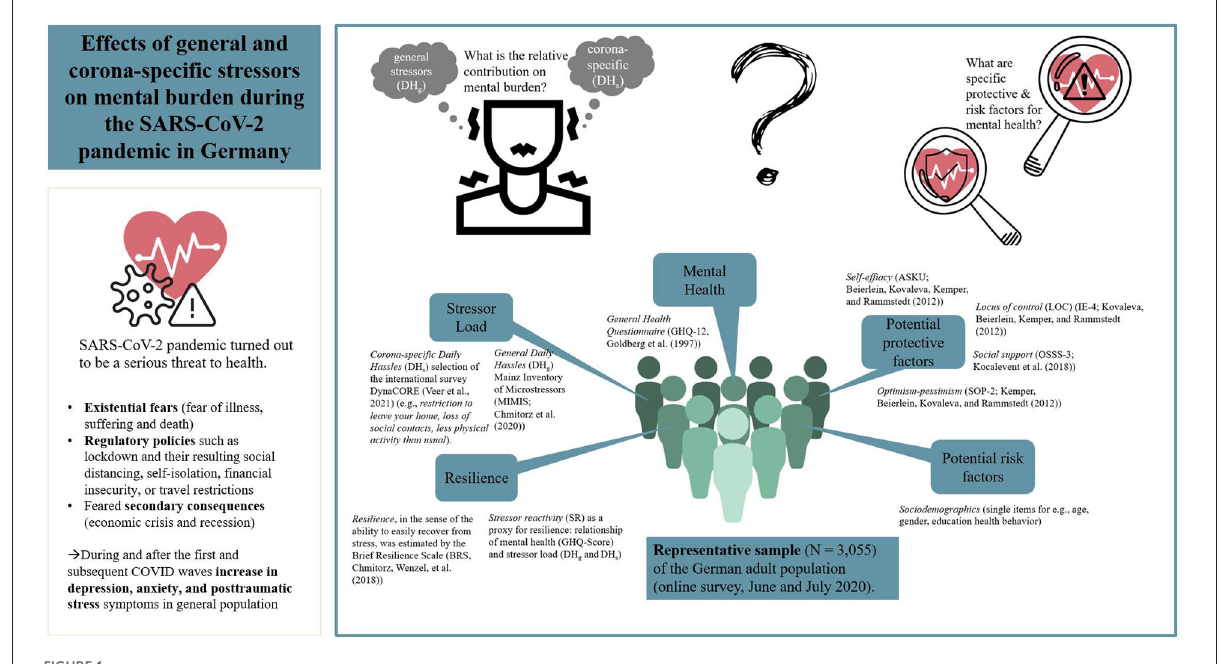
FIGURE1 Graphical representation of the study